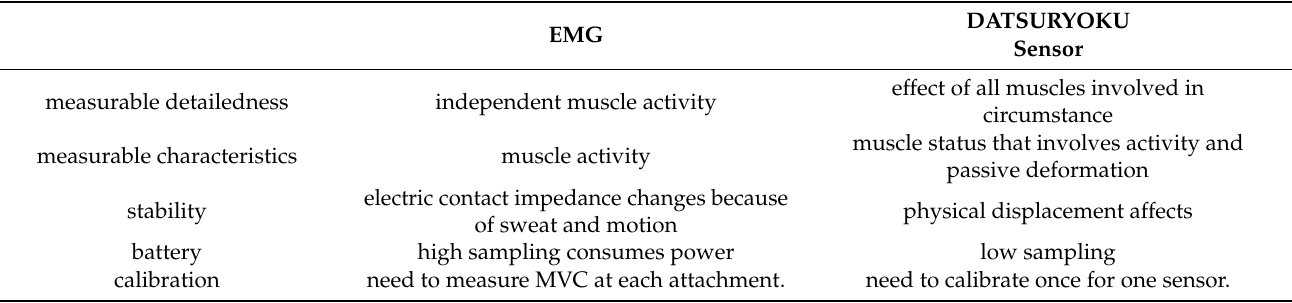
Table 3. Pros and cons comparing the DATSURYOKU sensor with